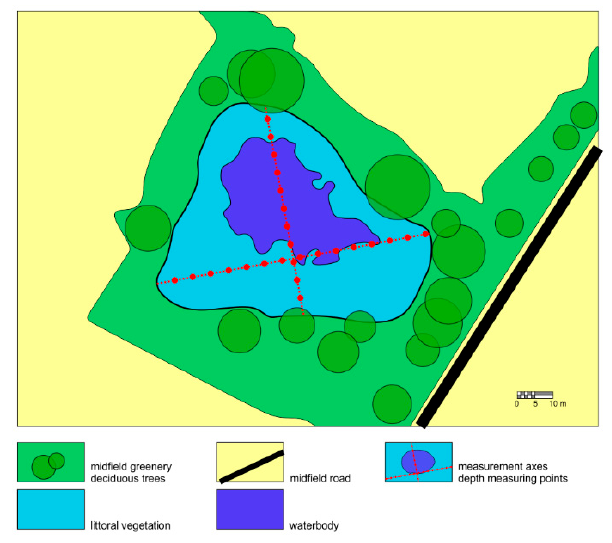
Figure 2. Waterbody depth and temperature measurement scheme (the example given is of pond No. 11).